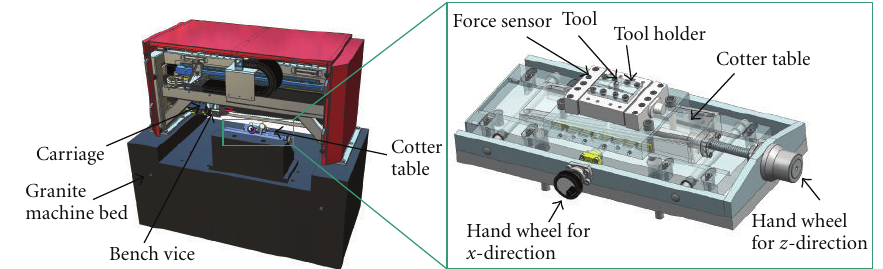
Figure 8: Setup of the novel analogy test bench for milling